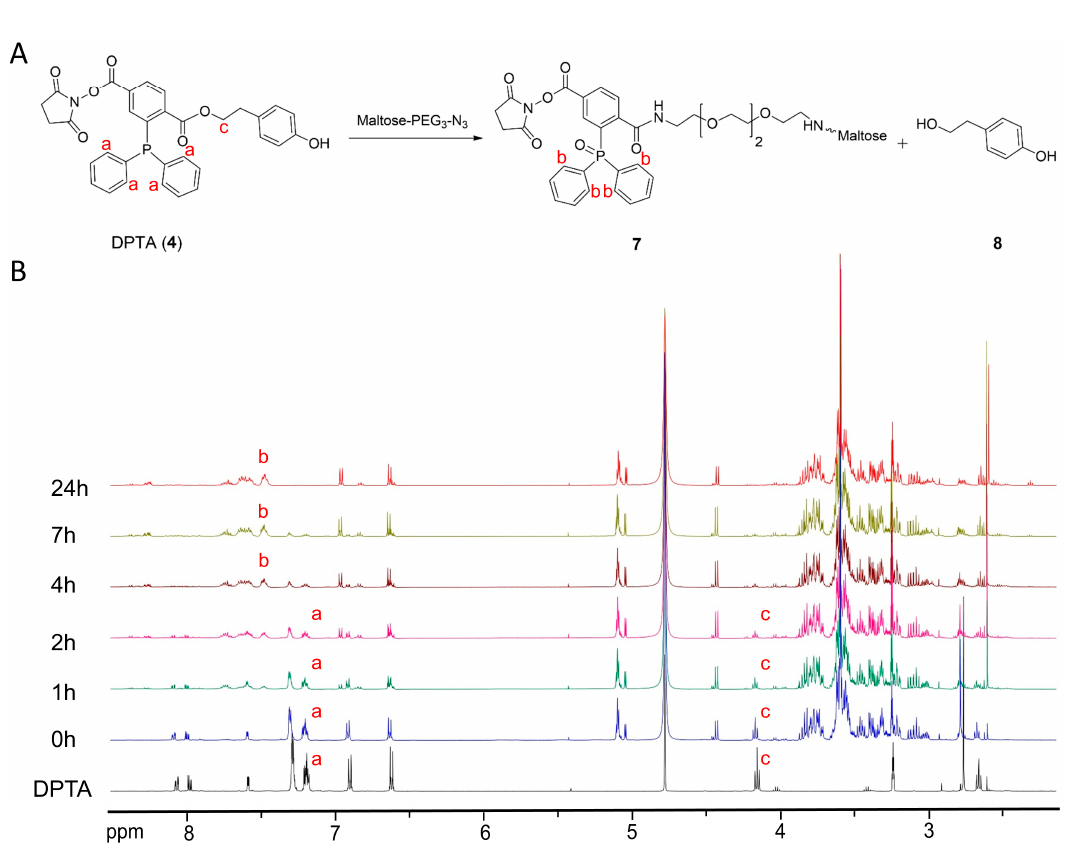
Figure 3. The reaction between DPTA and maltose-PEG 3 -azide leading to the generation of phosphine oxide (7) and the elimination of (8) ( A ). 1 H-NMR spectroscopic kinetic analysis of the reaction between DPTA and maltose-PEG 3 -azide ( B ). Marks “a”, “b”, and “c” in Figure 3B are the protons described in Figure 3A.